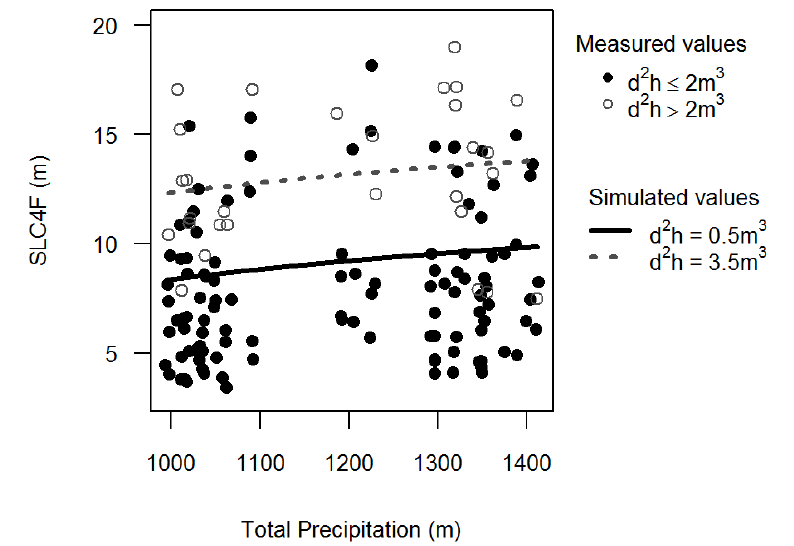
Figure 6. Effect of the annual amount of precipitations (mm) on the sum of the longest clearbole sections on each of the four faces ( SLC4F ) of the